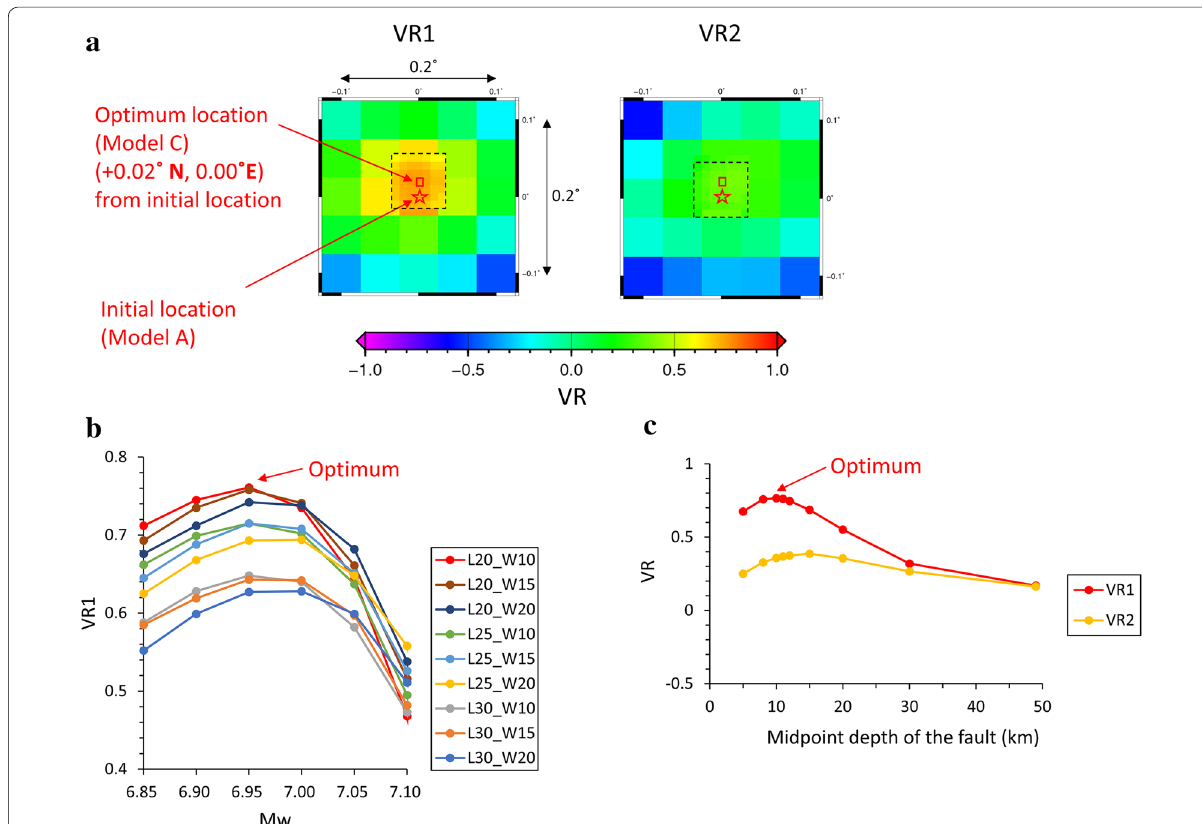
Fig. 6 Mean values of VR for model C after various parameters were changed from model A. a Changes in VR from shifting the horizontal location of model A (red star). The area within the dashed rectangle was searched in horizontal increments of 0.01° to find the optimal location (red square). b VR1 versus Mw for various combinations of L (km) and W (km) in model C. c VR for various fault depths between 5 and 50 km in model